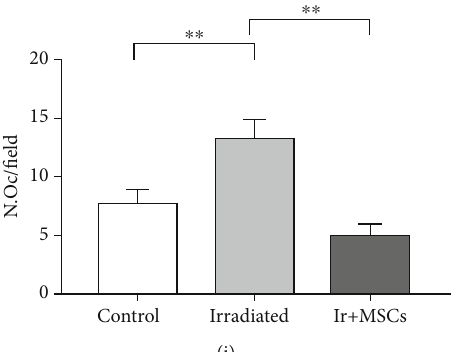
Figure 5: hUCB-MSCs can save bone loss by improving the bone marrow microenvironment. (a) H&E of humerus sections from mice with control, MSC treatment, and irradiated. The black line showed the distance between the bone surface and the adjacent bone marrow tissue (scale bar, 100 μ m). (b) Transmission electron microscopy images of humerus sections from mice with control, MSC treatment, and irradiated. The black arrowhead points to osteoprogenitor cells. The white arrowhead points to immature osteocytes and osteogenic phenomena (scale bar, 50 μ m). (c) α -SMA staining of humerus sections from mice with control, MSC treatment, and irradiated (scale bar, 25 μ m). (d) Immunohistochemistry of humerus sections from mice with control, MSC treatment, and irradiated (scale bar, 250 μ m). (e) H&E of humerus sections from mice with control, MSC treatment, and irradiated. The black arrowhead points to fat cells (scale bar, 250 μ m). (f) TRAP staining of humerus sections from mice with control, MSC treatment, and irradiated. The black arrowhead points to osteoclasts (scale bar, 25 μ m). (g) Statistics of osteoid width in the control, MSC treatment, and irradiated groups. (h) Statistics of fat particles in the control, MSC treatment, and irradiated groups. (i) Statistics of osteoclasts in the control, MSC treatment, and irradiated groups. All data are mean ± SD ; ∗ P < 0 : 05 ; ∗∗ P < 0 : 01